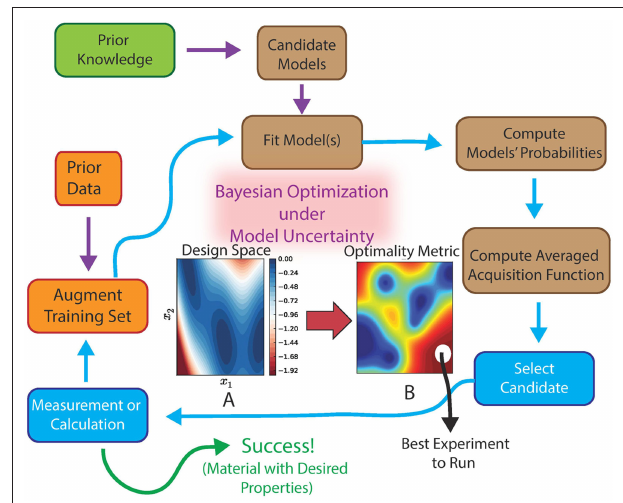
FIGURE 2 | Schematic of the proposed framework for an autonomous, efficient materials discovery system as a realization of Bayesian Optimization under Model Uncertainty (BOMU). Initial data and a set of candidate models are used to construct a stochastic representation of an experiment/simulation. Each model is evaluated in a Bayesian sense and its probability is determined. Using the model probabilities, an effective acquisition function is computed, which is then used to select the next point in the materials design space that needs to be queried. The process is continued iteratively until target is reached or budget is exhausted. Used with permission from Talapatra et al.